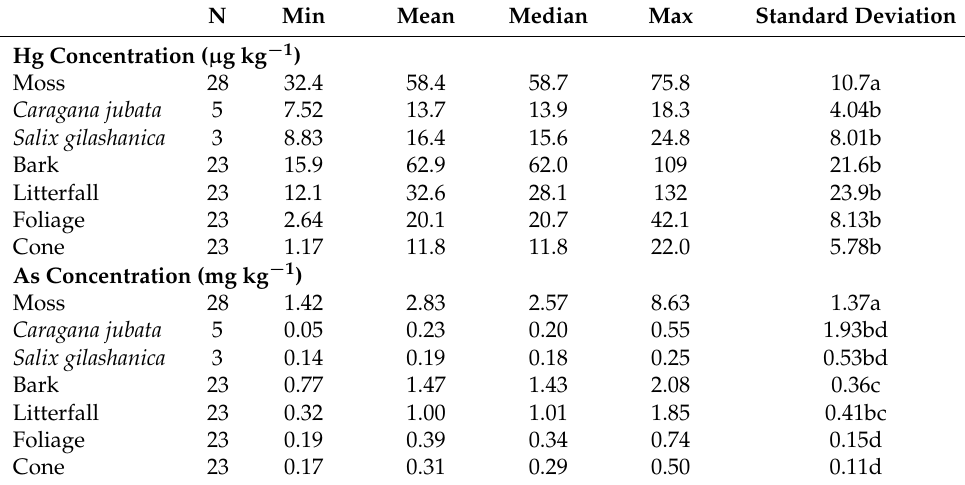
Table 2. The Hg and As concentrations in